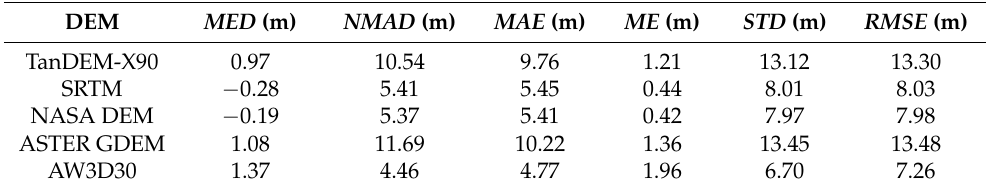
Table 3. Quality indicators for the TanDEM-X90, SRTM, NASA, ASTER GDEM, and AW3D30 digital elevation models for the study